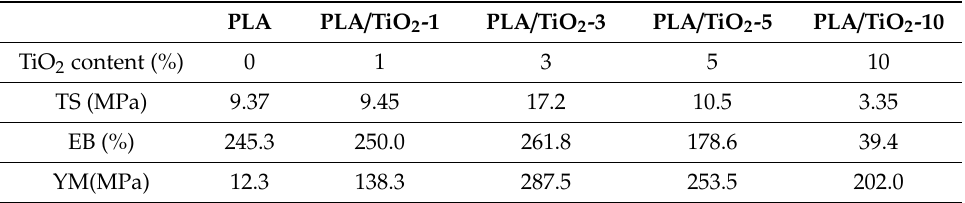
Table 1. Mechanical properties of PLA and PLA/TiO 2 composites [29].